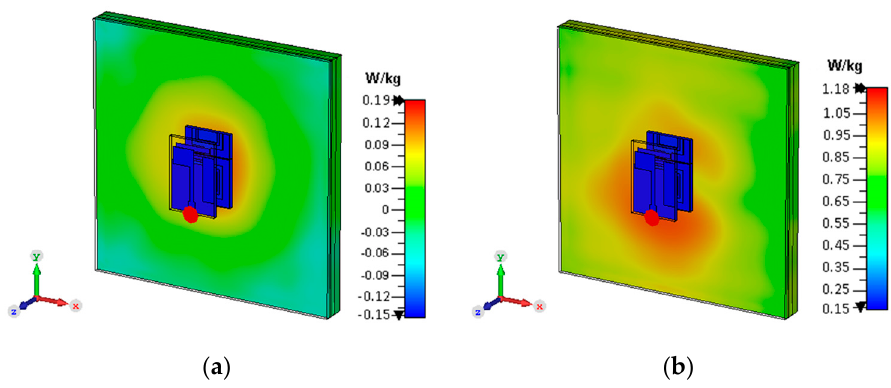
Figure 21. SAR of the AMC-backed antenna: ( a ) at 2.45 GHz; ( b ) at 5.8 GHz.